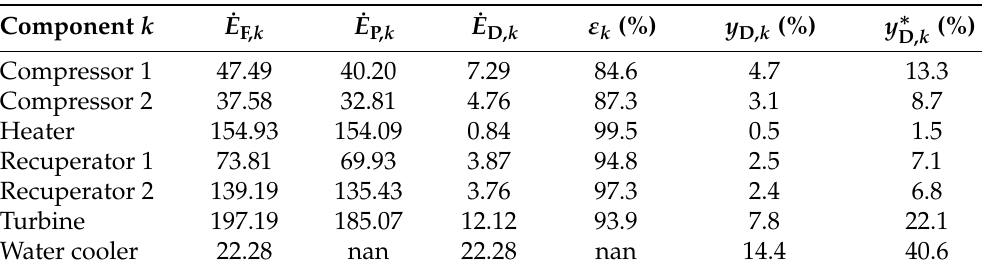
Table 7. sCO 2 power cycle—Results of the exergy analysis, components. If not given, dimension of data is